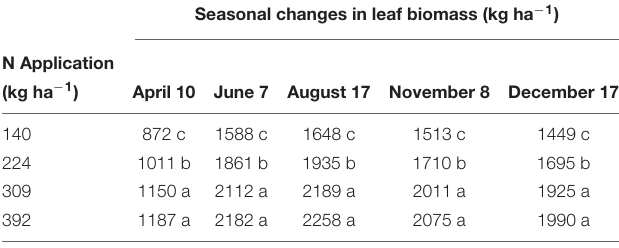
TABLE 3 | Seasonal changes in leaf biomass (kg ha − 1 ) during the season of